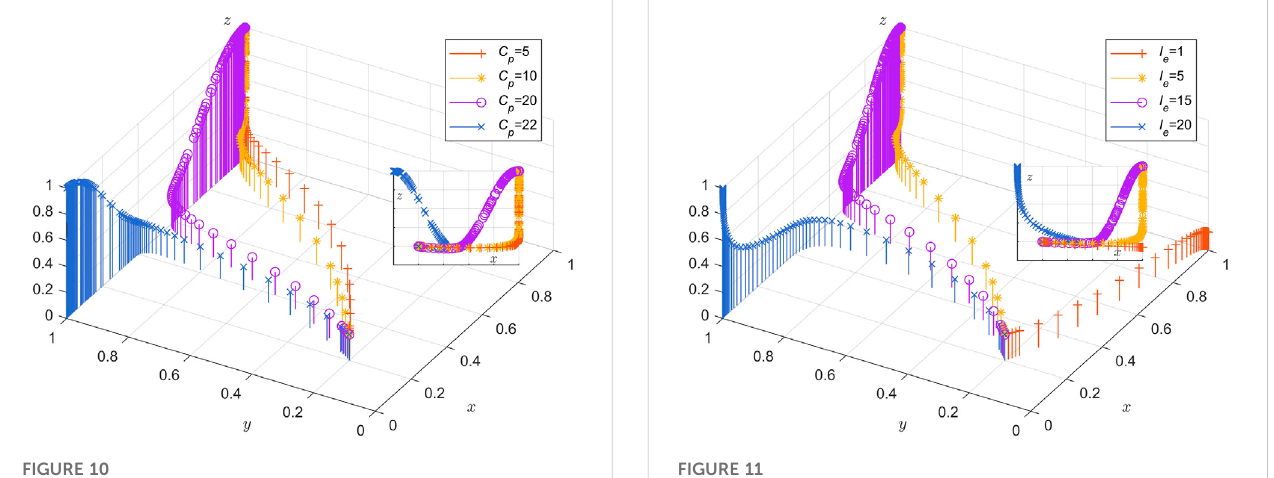
FIGURE 11 The in fl uence of subsidized Ie on the evolution of stakeholder behavior.